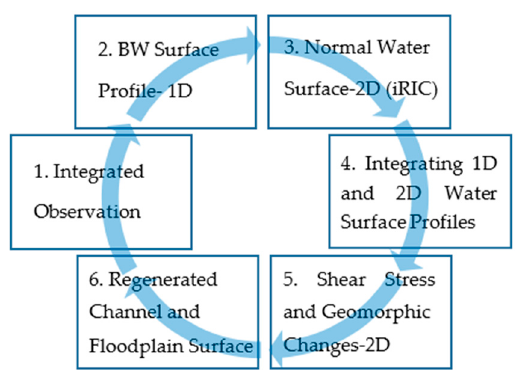
Figure 2. This integrative iterative modelling approach was developed to address morphological alterations in a complex domain including normal, transitional and backwater (BW) zones.